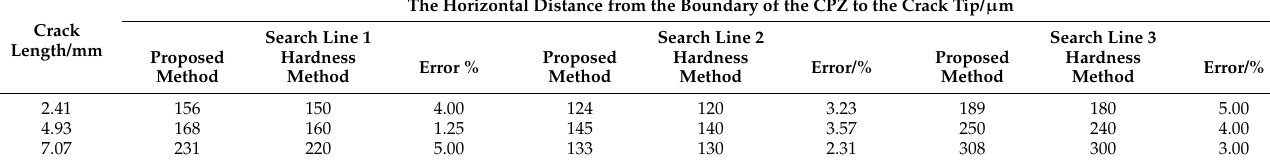
Figure 17. Hardness distribution on three search lines with different crack lengths: ( a ) Crack length: 2.41 mm; ( b ) crack length: 5.13 mm; ( c ) crack length: 7.07 mm. Table 4. Comparison of two different methods of CPZ measurement.